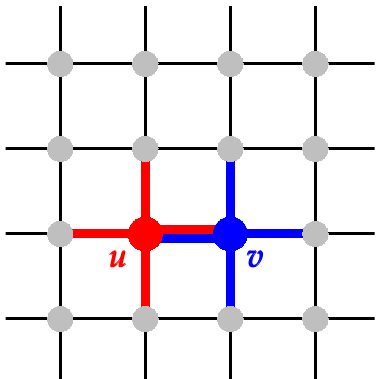
Figure 3. A pictorial illustration of calculation of R IC ( u , v ) for a two-dimensional grid. The blue edges, when shifted to the left by one unit, coincide with the red edges, giving E MD ( V u , v , P u , P v ) It can also be argued that E MD ( V u , v , P u , P v ) E MD ( V u , v , P u , P v ) =